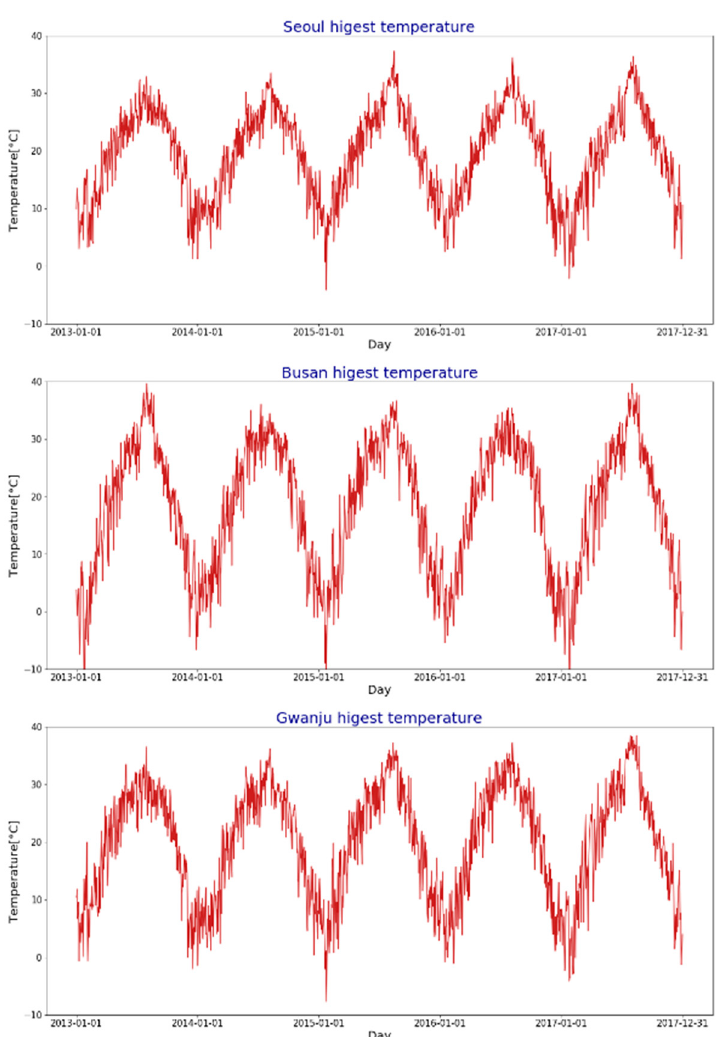
Figure 7. Highest temperatures of day in Seoul, Gwangju and Busan during 2013–2017.